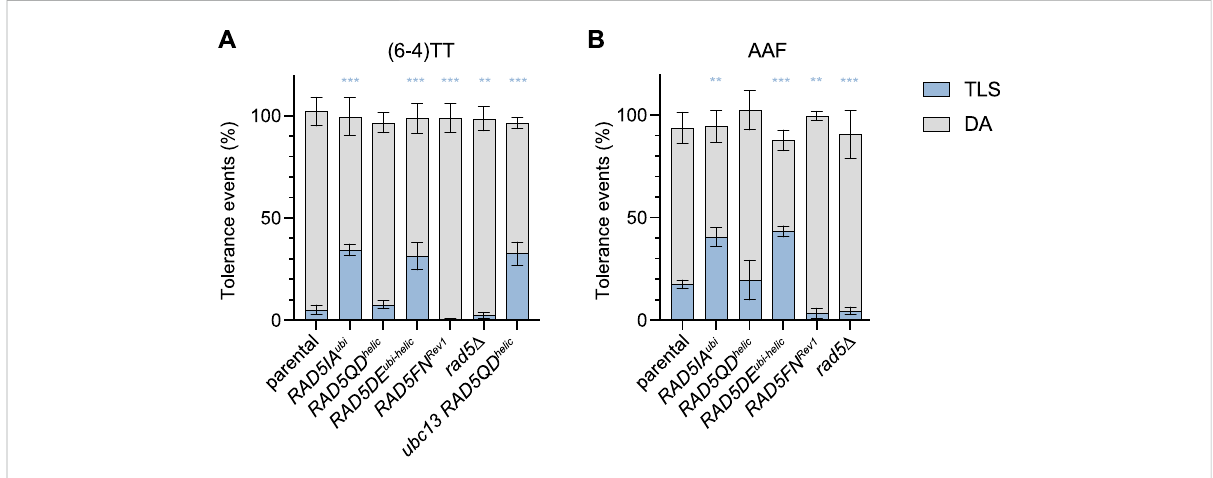
FIGURE 2 Partitioning ofDDTpathwaysthrough(6 — 4)TT (A) andN2dG-AAF (B) lesionsindomain-speci fi cRad5mutants.Toleranceevents representthe percentage of cells able to survive in presence of the integrated lesion compared to the lesion-free control. The data represent the average and standard deviation of at least three independent experiments. Unpaired t -test was performed to compare TLS values from the different mutants to the parental strain (* p < 0.05; ** p < 0.005; *** p <